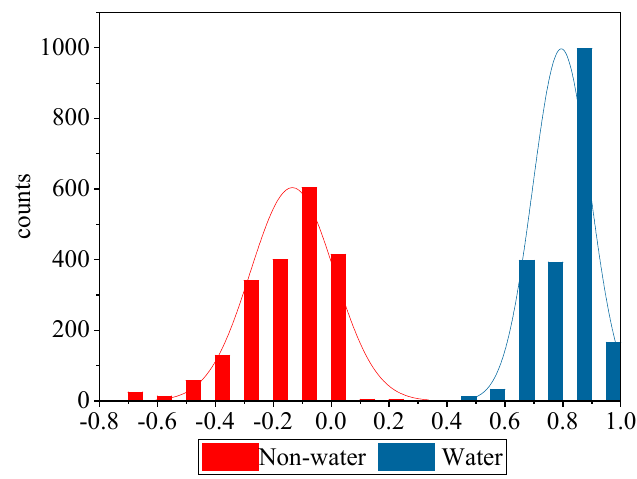
Figure 2. Histogram of water and non-water pixels. The x- and y-axis denote the value of the modified normalized difference water index (MNDWI) of each pixel and the number of pixels, respectively.